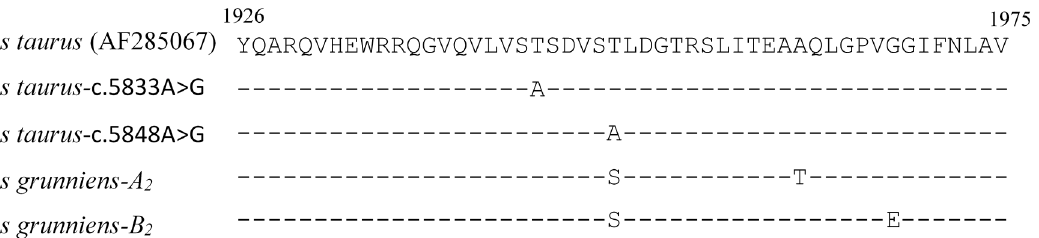
Figure 1. Polymerase Chain Reaction Single-Stranded Conformational Polymorphism (PCR-SSCP) banding patterns for the two regions of yak Fatty acid synthase gene ( FASN ) analyzed. ( a , b ) represent the FASN exon 24-intron 24 and exon 34 amplification regions, respectively.